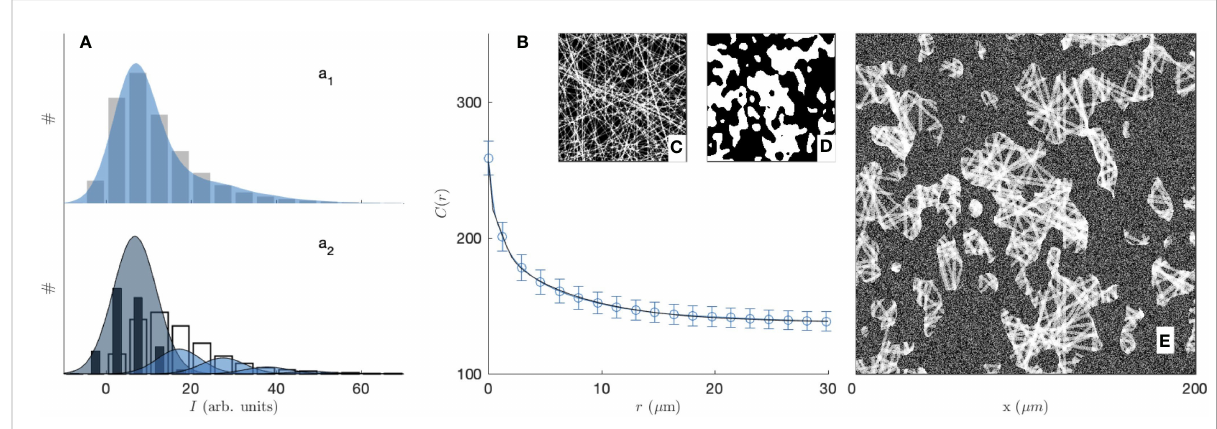
FIGURE 6 Greytone fi bre-aggregates model of the 2 mg/mL type-I collagen gel, imaged by fl uorescence microscopy, with (a1) histogram of grey levels displaying pixel counts (#) against their intensity (bars: experimental values; blue shade: model), (B) the correlation function (dots: experimental value; solid line: model), as well as realizations of the fi bres (C) , aggregates (D) and complete model (E) . In (a2) the values inferred from the segmented images in the pores (back bars) and fi bre areas (white bars) are compared with the model contributions to the background (dark shade) and increasing number of overlapping fi bres (bright